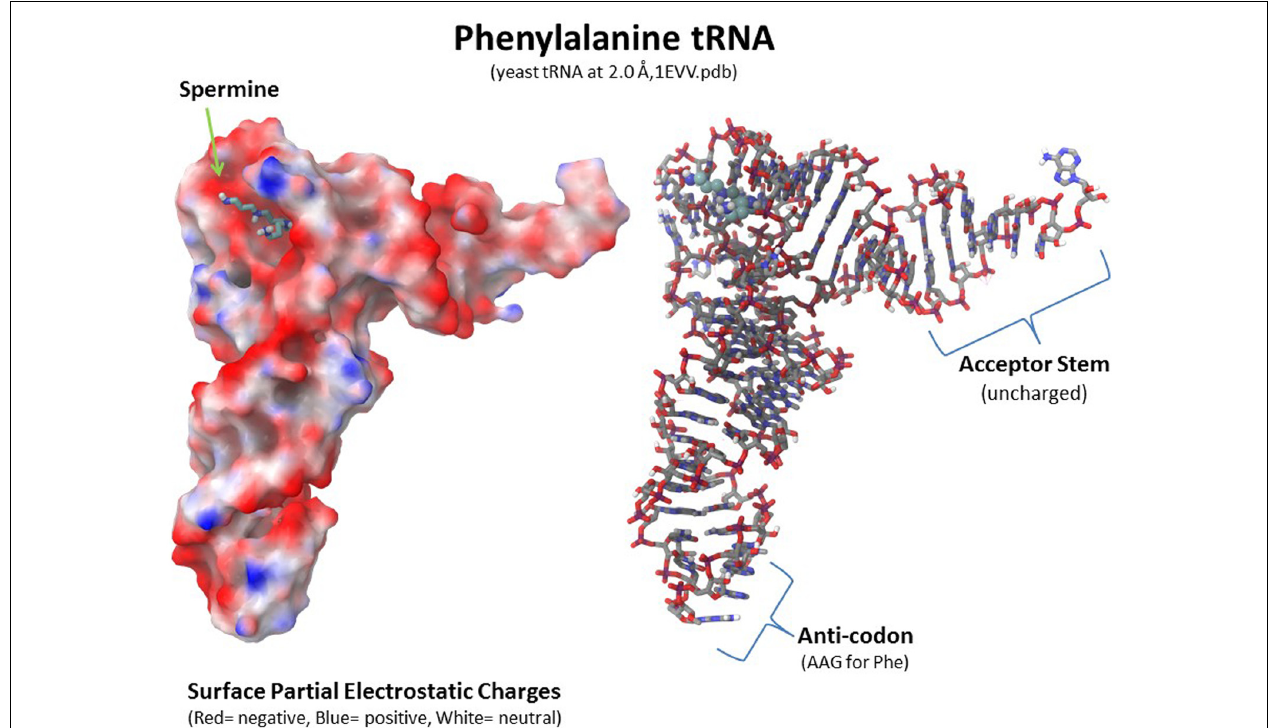
nucleoli as transient factors initiating folding and as stabilizing factors in the final macromolecular complexes. Xaplanteri etal. (2005) identified more than 30 sites in the 23S rRNA and more than 100 sites in the 50S ribosomal subunit at which spermine or spermidine could potentially interact with the RNA and